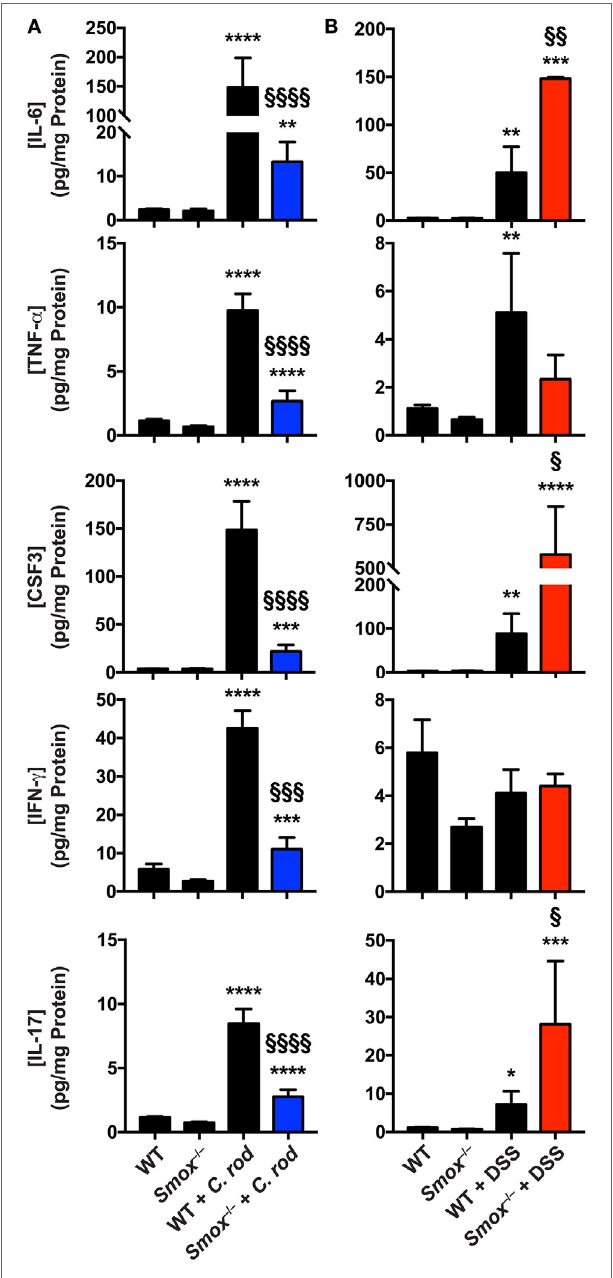
FigUre 3 | Cytokines and chemokines in colonic tissues. Protein lysates from the colons of naïve wild­type (WT) and Smox − / − mice as well as Citrobacter rodentium ­infected mice (a) and dextran sulfate sodium (DSS)­treated animals (B) were used to determine the concentration of cytokines and chemokines by Luminex assay. * P < 0.05, ** P < 0.01, *** P < 0.001, and **** P < 0.0001 compared with uninfected animals; § P < 0.05, §§ P < 0.01, §§§ P < 0.001, and §§§§ P < 0.0001 compared with WT mice infected with C. rodentium infection or DSS